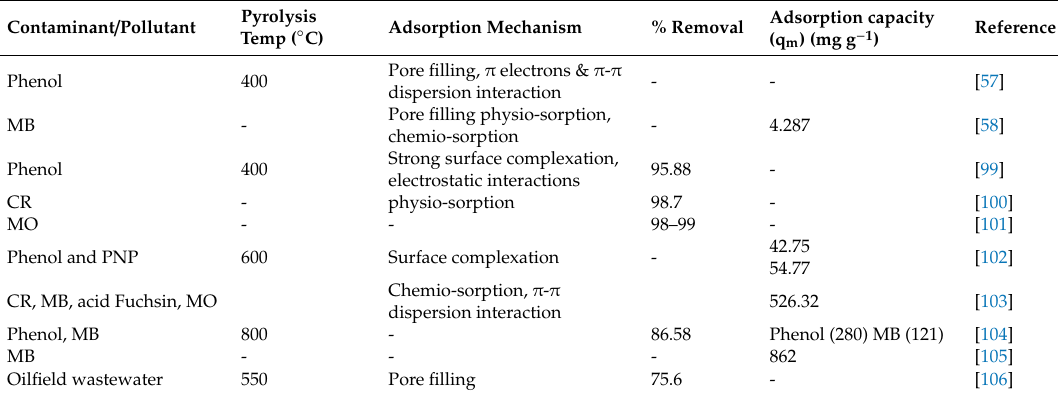
Table 6. Adsorption capacity of some organic compounds on